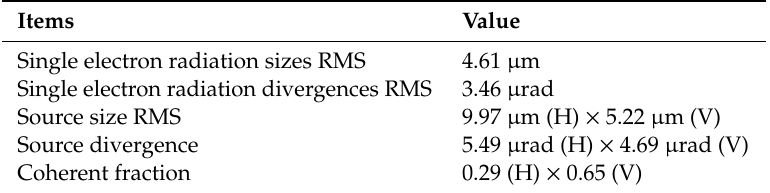
Table 4. Source characteristic photon beam size and divergence for selected B4 beamline